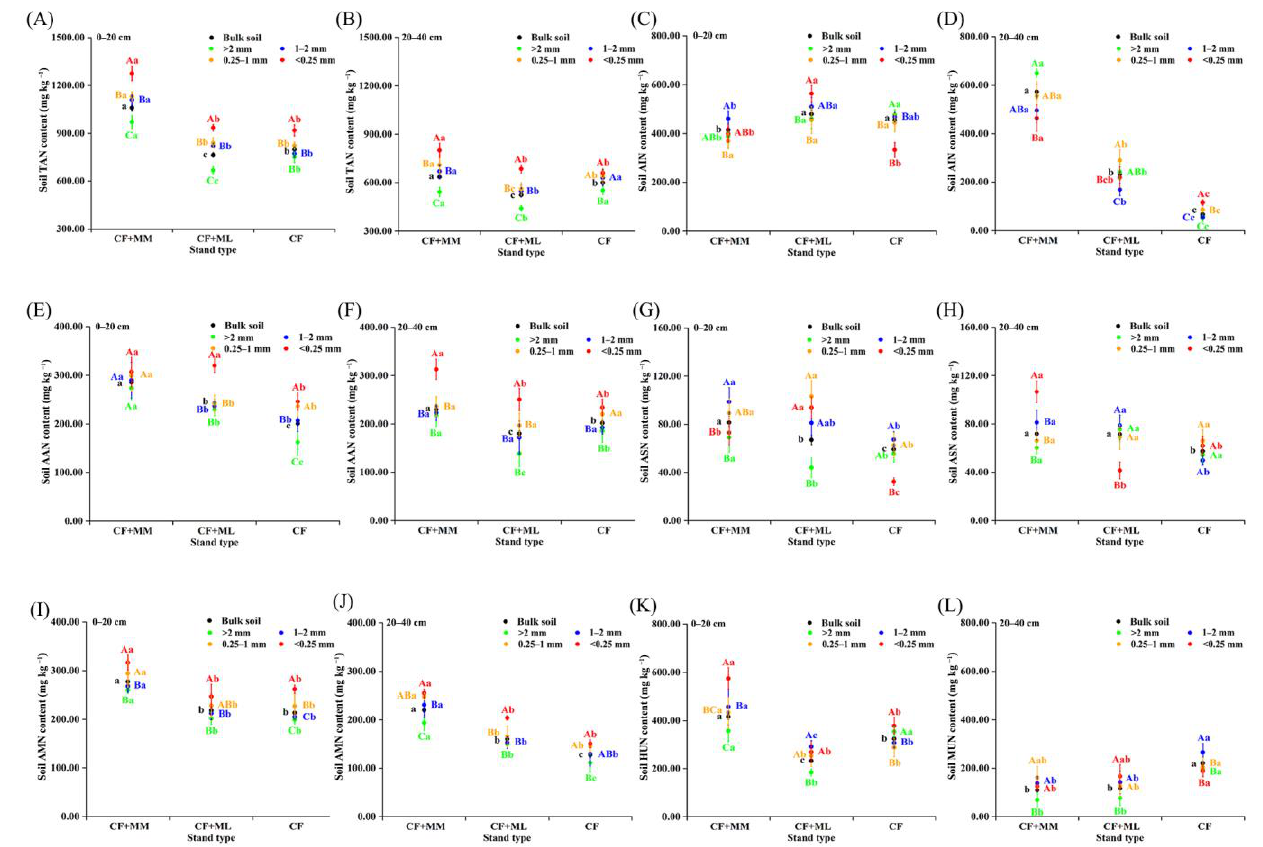
Figure 3. Soil aggregate-associated total acidolysable nitrogen (TAN), nonacidolyzable nitrogen (AIN), amino acid nitrogen (AAN), amino sugar nitrogen (ASN), cidolyzable ammonia nitrogen (AMN), and unknown acidizable nitrogen (NUN) contents in Chinese fir plantations with different stand types in 0 – 20 cm ( A , C , E , G , I , K ) and 20 – 40 cm ( B , D , F , H , J , L ) soil depth. Different capital letters stand for significant differences ( p < 0.05) among different aggregate sizes in the same forest types. Different lowercase letters represent significant differences ( p < 0.05) among different stand types with the same fraction.